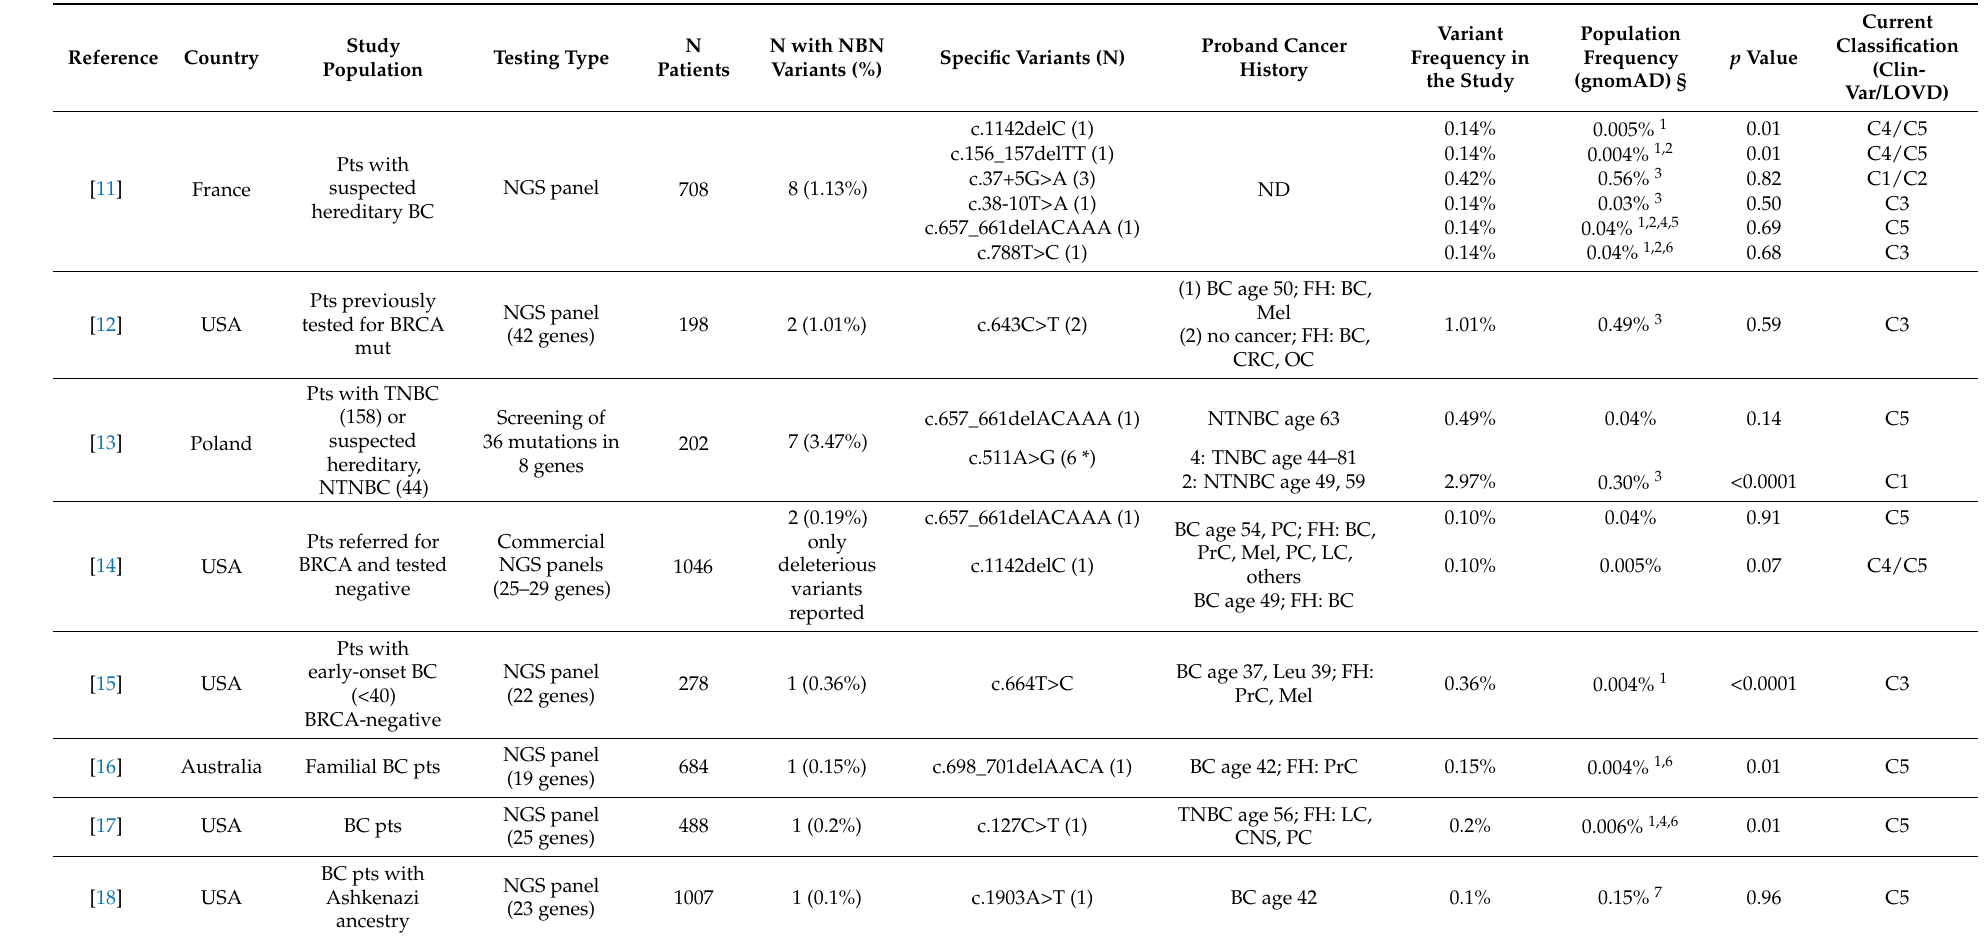
Table 1. Studies reporting variants in the NBN genes detected through multigene